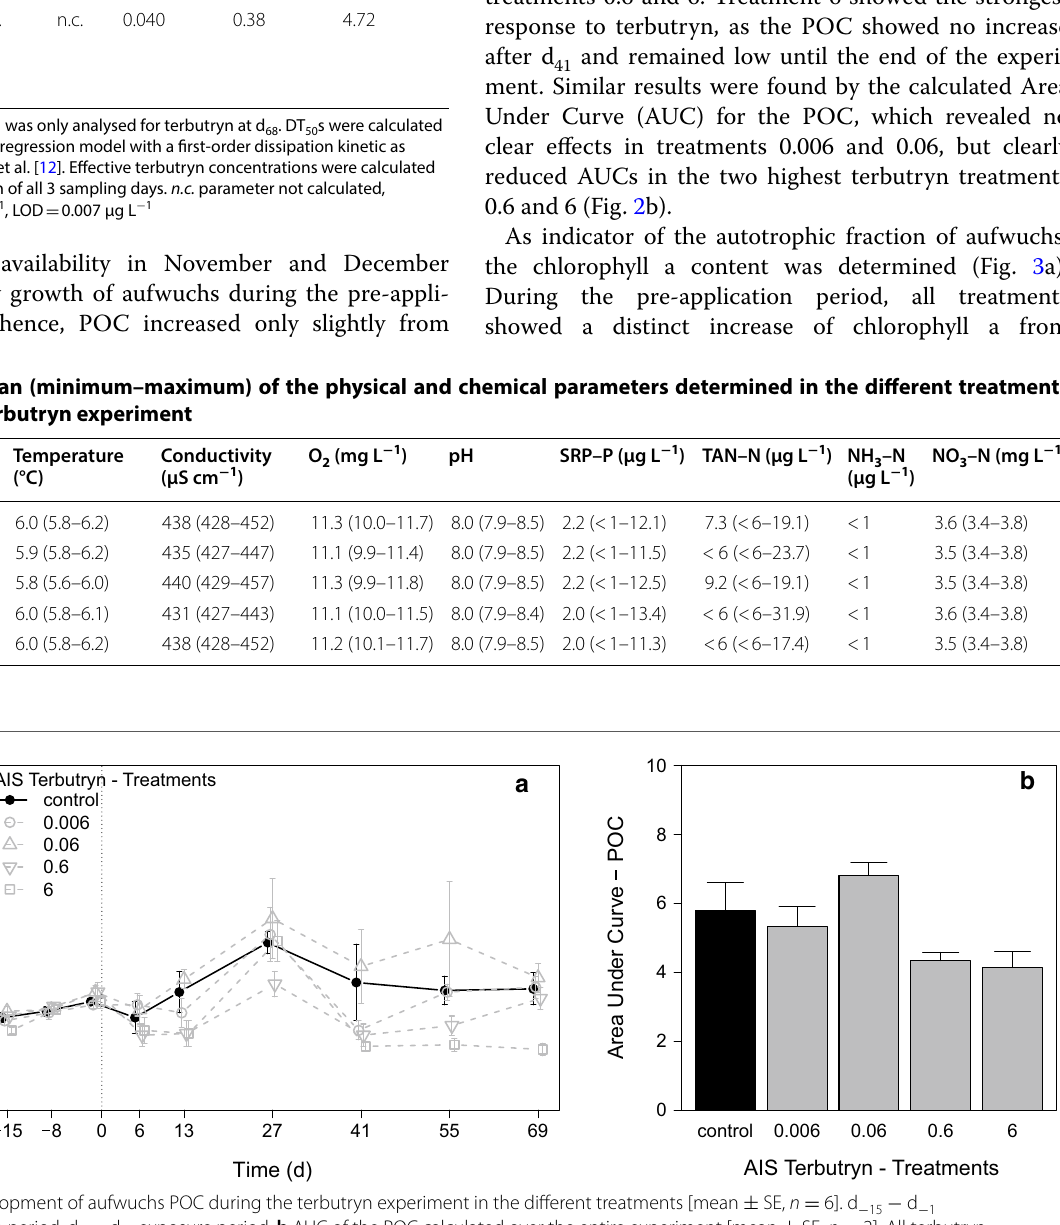
0 − d 69 exposure period. b AUC of the POC calculated over the entire experiment [mean ± SE, n = 2]. All terbutryn